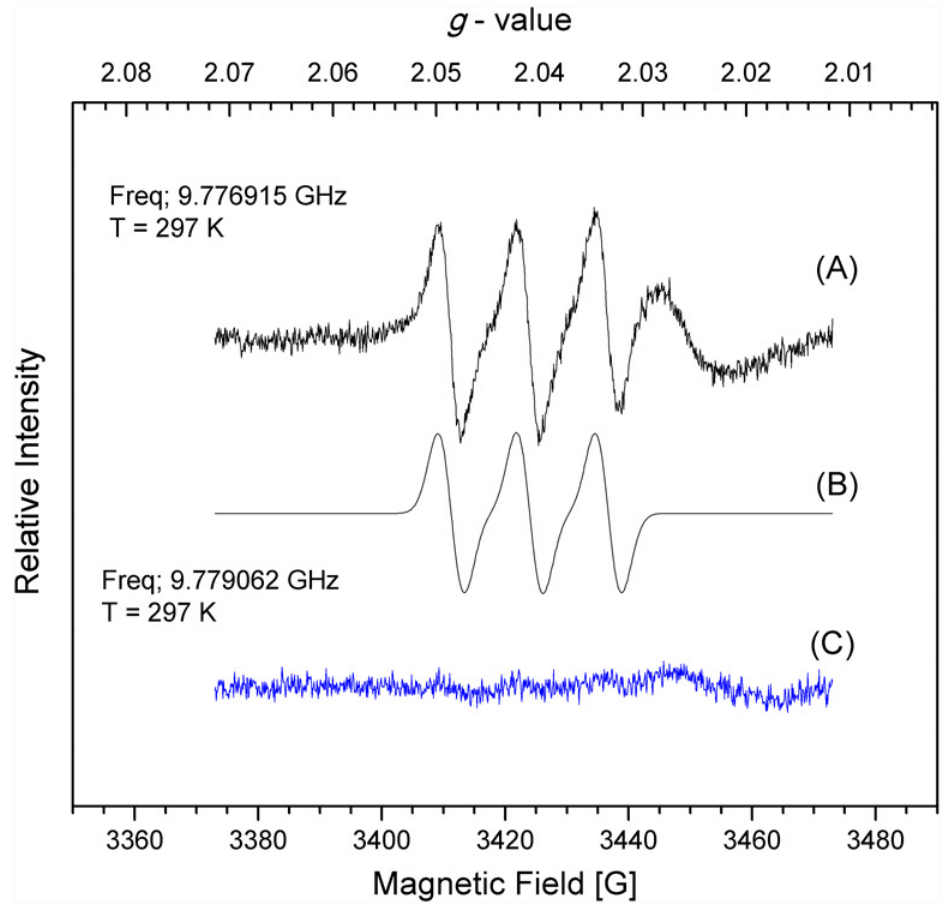
Fig 3. Nitric oxide detection by EPR in P. patens protonema. A) Plants grew for seven days on simple Knop media or C) on medium supplemented with 30 μ M sodium tungstate. Homogenized tissues were mixed with (MGD) 2 Fe(II) and incubated for 1h. EPR spectra were recorded at approximately 9.8 GHz (X-band) and 100 kHz modulation (Microwave frequency, 9.776915 GHz for A and 9.779062 GHz for C; microwave power, 2.0 mW; modulation amplitude: 0.3 mT; T, 297 K). Each graph is a representative spectrum of four independent experiments. B represents the simulated spectrum of